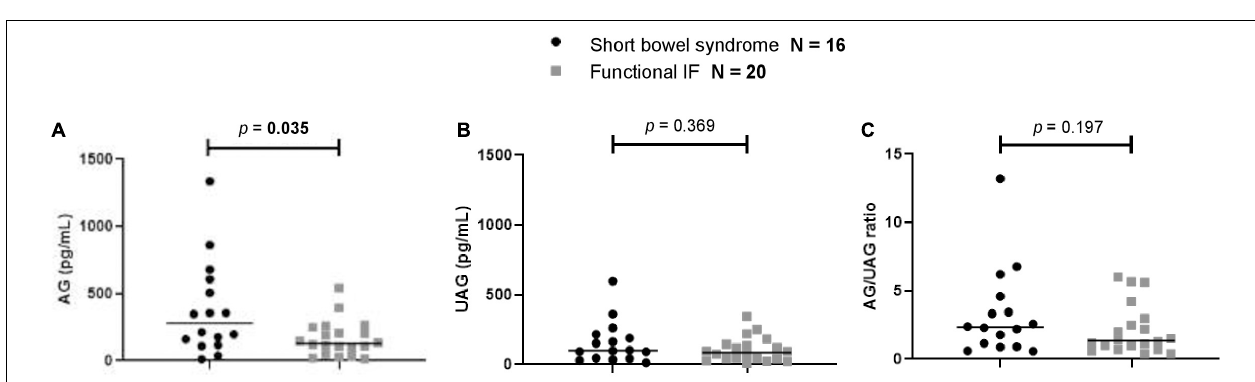
FIGURE 3 | Comparison of first measurement of (A) AG, (B) UAG levels, and (C) AG/UAG ratios between patients with functional IF (gray) and patients with short bowel syndrome (black). AG, acylated ghrelin; IF, intestinal failure; UAG, unacylated ghrelin. Every (black or gray) symbol represents one ghrelin measurement in one patient. The median is shown as a horizontal line in front of the symbols. Patient groups were compared using Mann–Whitney U